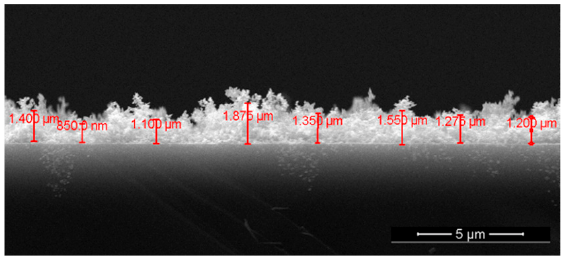
Figure 3. Cross-section SEM image of the SnO 2 film deposited at 700 mTorr.